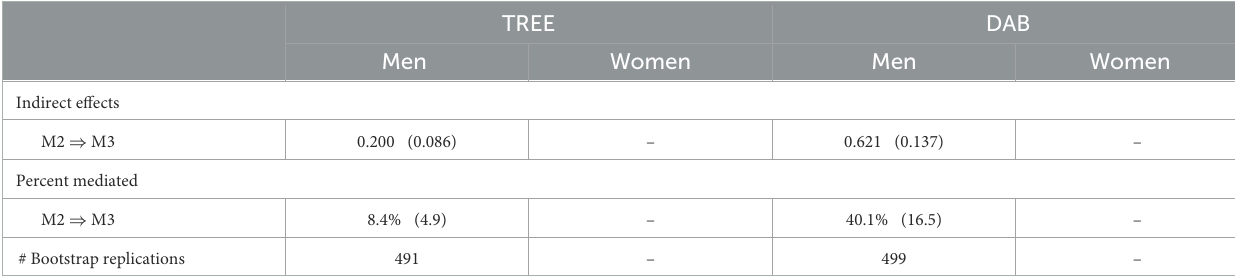
TABLE 2 Selected indirect effects and percentage mediated of migration background on upper secondary track attended in Table